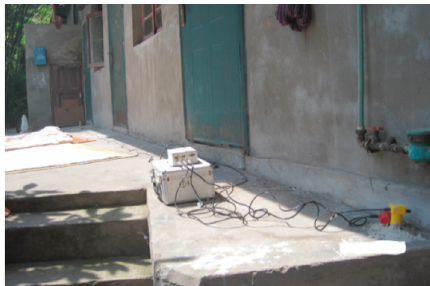
Figure 1: Photograph showing the UBOX-5016 instrument and vibration